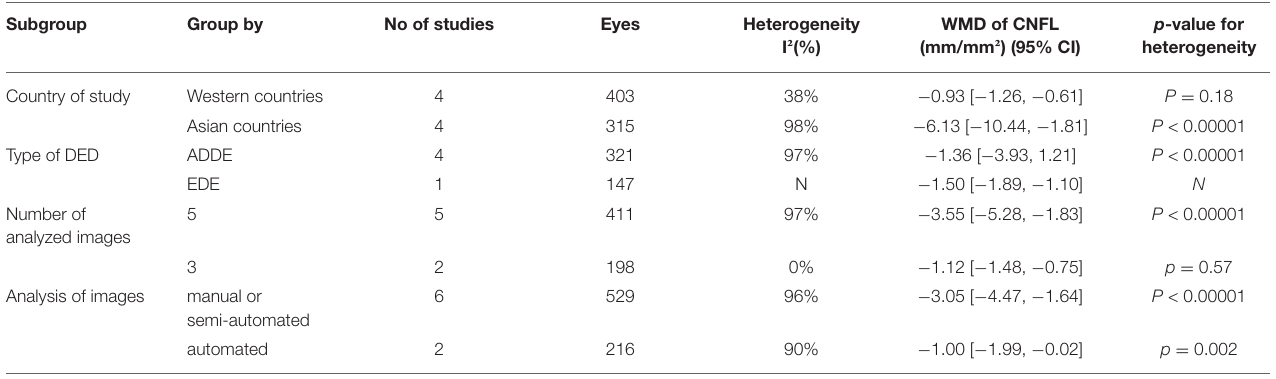
TABLE 3 | CNFL in the central subbasal nerve plexus by various subgroup meta-analyses. Subgroup